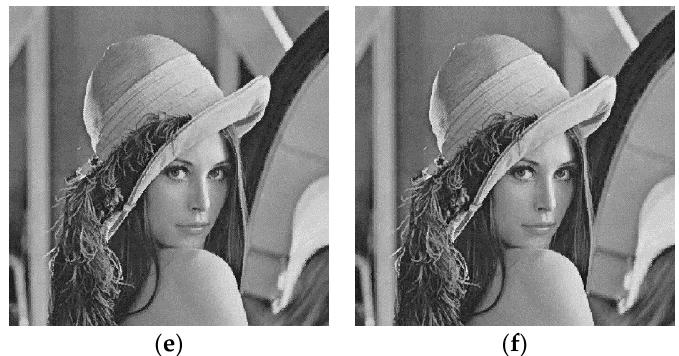
Figure 16. Visual investigation on Image Set 2 with quality factor 𝑄 = 10 : ( a ) input image; ( b ) JPEG decoded image; ( c ) ODBTC; ( d ) EDBTC; ( e ) DDBTC; and ( f ) DDBTC Gaussian method.